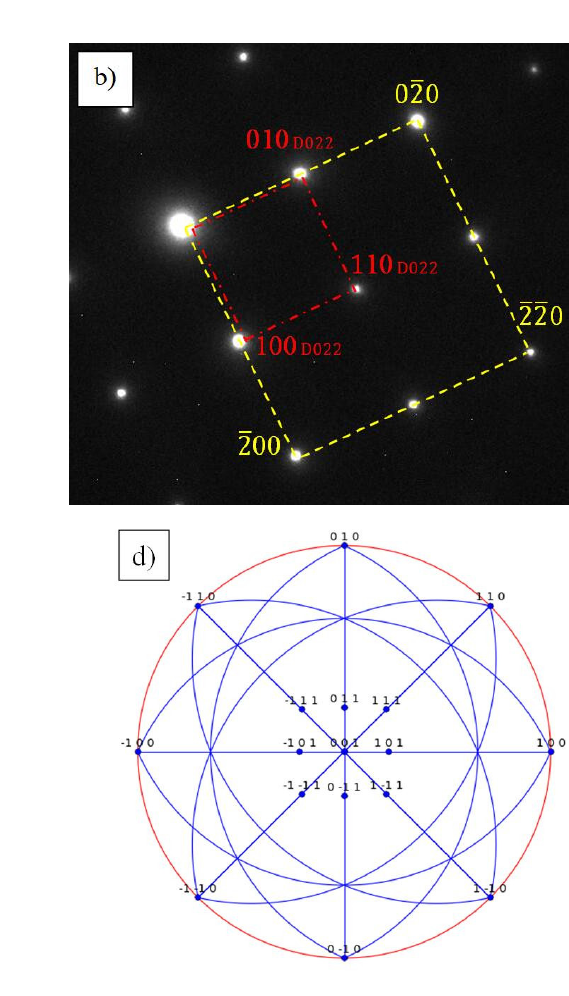
Figure 12. The SEM, XRD, and stress-strain curves of CoCrFeAlTa 0.16 . ( a ) The SEM and XRD images at 50 h annealing state; ( b ) The stress-strain curves of different heat treatment states.